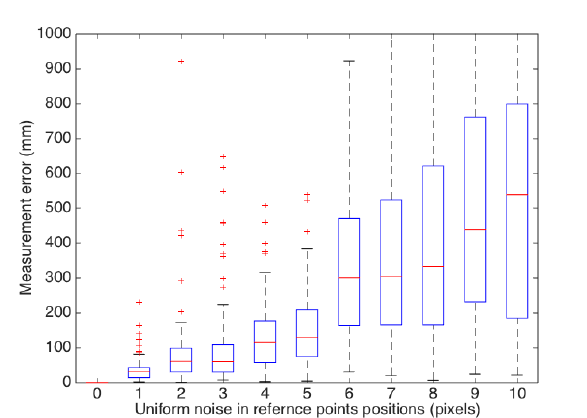
Figure 7. Dependency between noise in the position of reference points and the measurement error of the MLZ